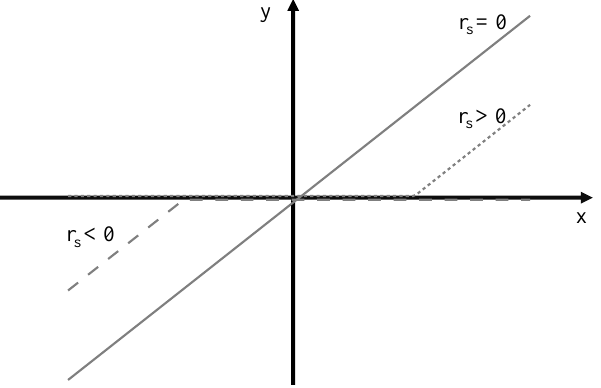
Figure 6. Superposition operator characteristic for different threshold values r S